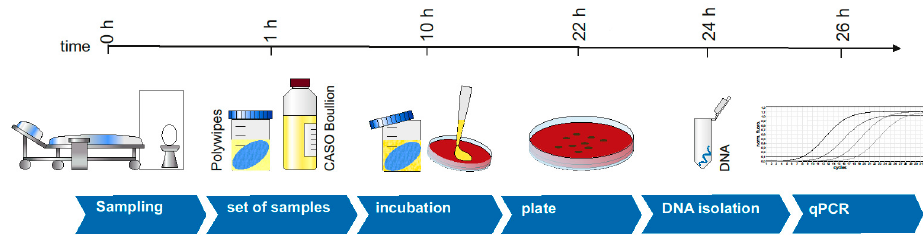
Figure 1. Study design. Schematic overview of the individual steps in the methodology.